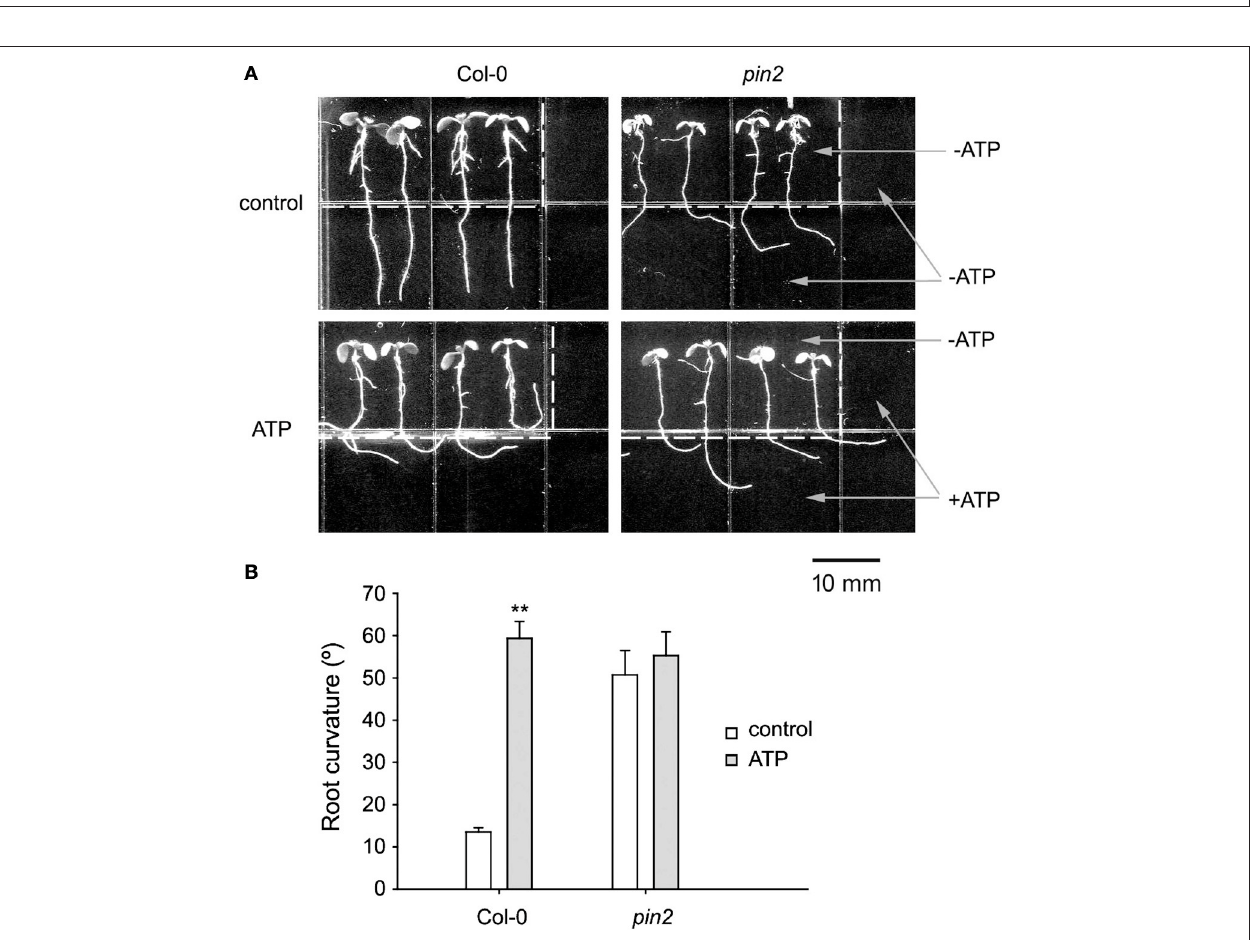
FIGURE 6 | PIN2 null mutant did not respond to eATP. (A) Seedlings of Col-0 and PIN2 null mutant ( pin2 ) grown in U-shape jointed medium containing 0 (control) or 0.5 mM ATP (ATP) in the lower part and two sides, respectively. Seedlings were photographed 5 days after transplantation. The dotted line marks the joint line of the two media. The scale bar is showed below. (B) Effect of ATP on root curvature. Root curvature of at least 30 seedlings was measured, and data from 3 replicates were calculated to get the mean ± SD. Student’s t -test p -values: ** p < 0.01.